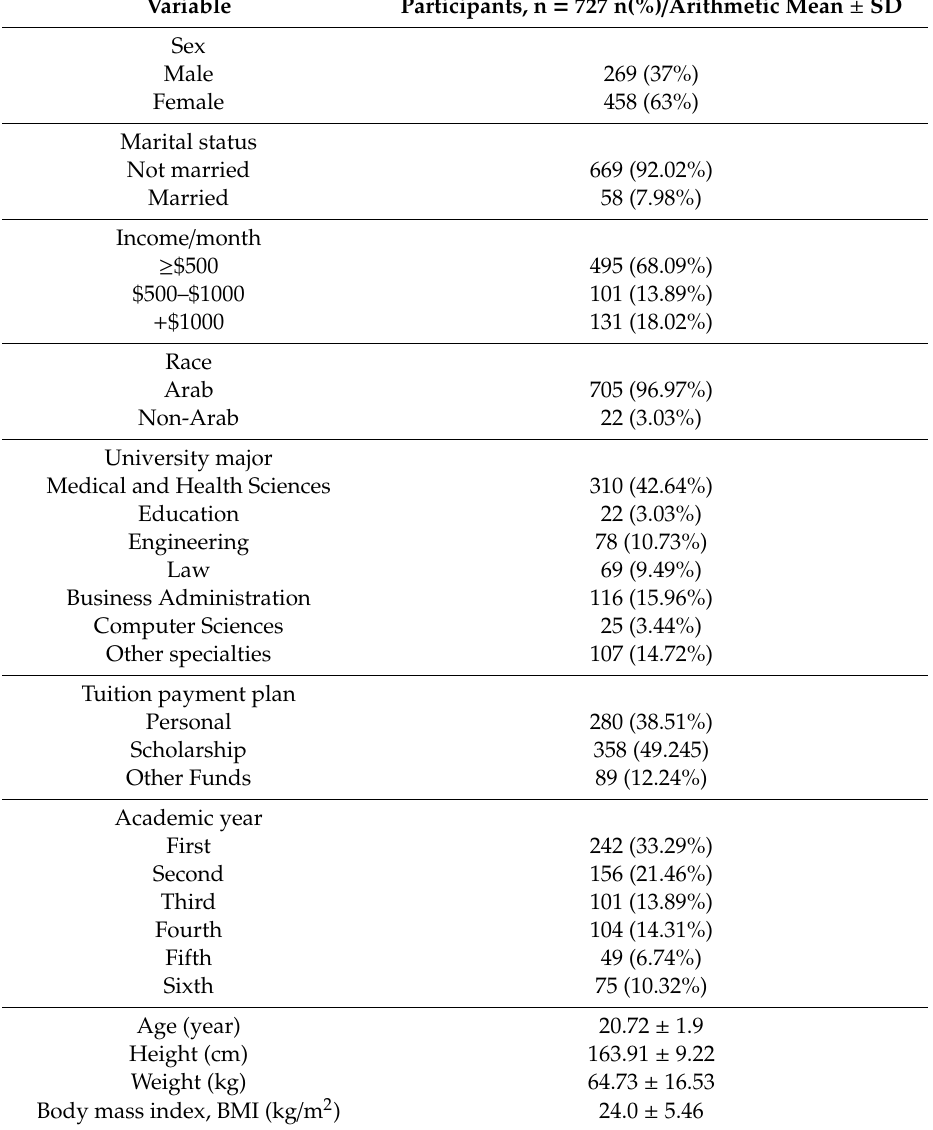
Table 1. Descriptive sociodemographic and anthropometric characteristics of the study